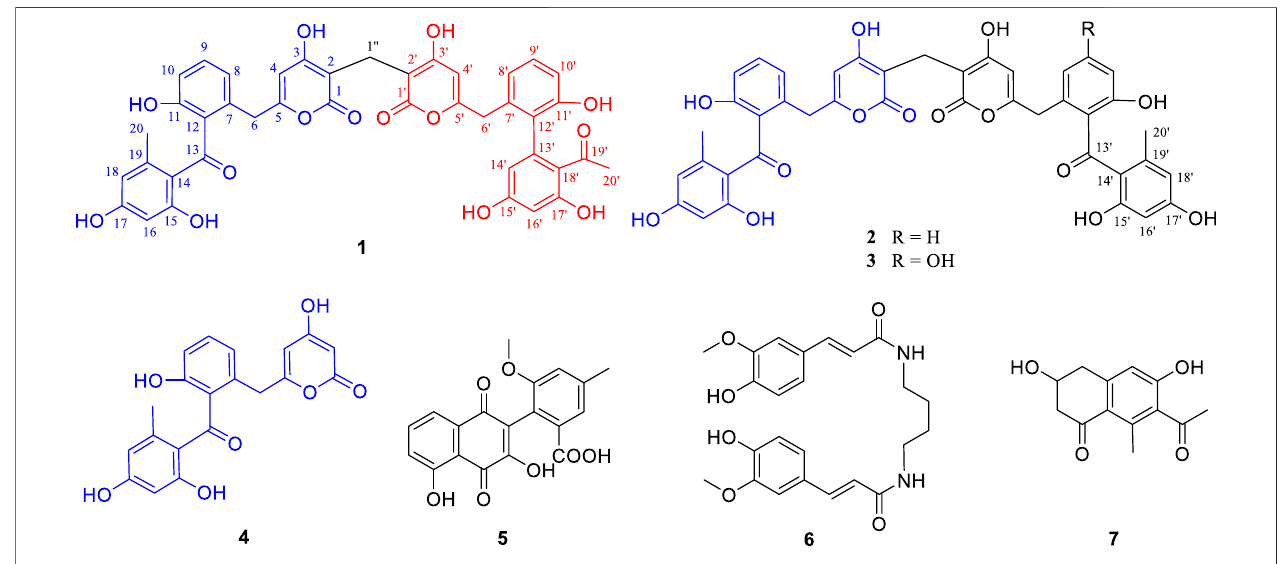
FIGURE 1 | Chemical structures of compounds isolated from Streptomyces sp. HS-3-L-1.